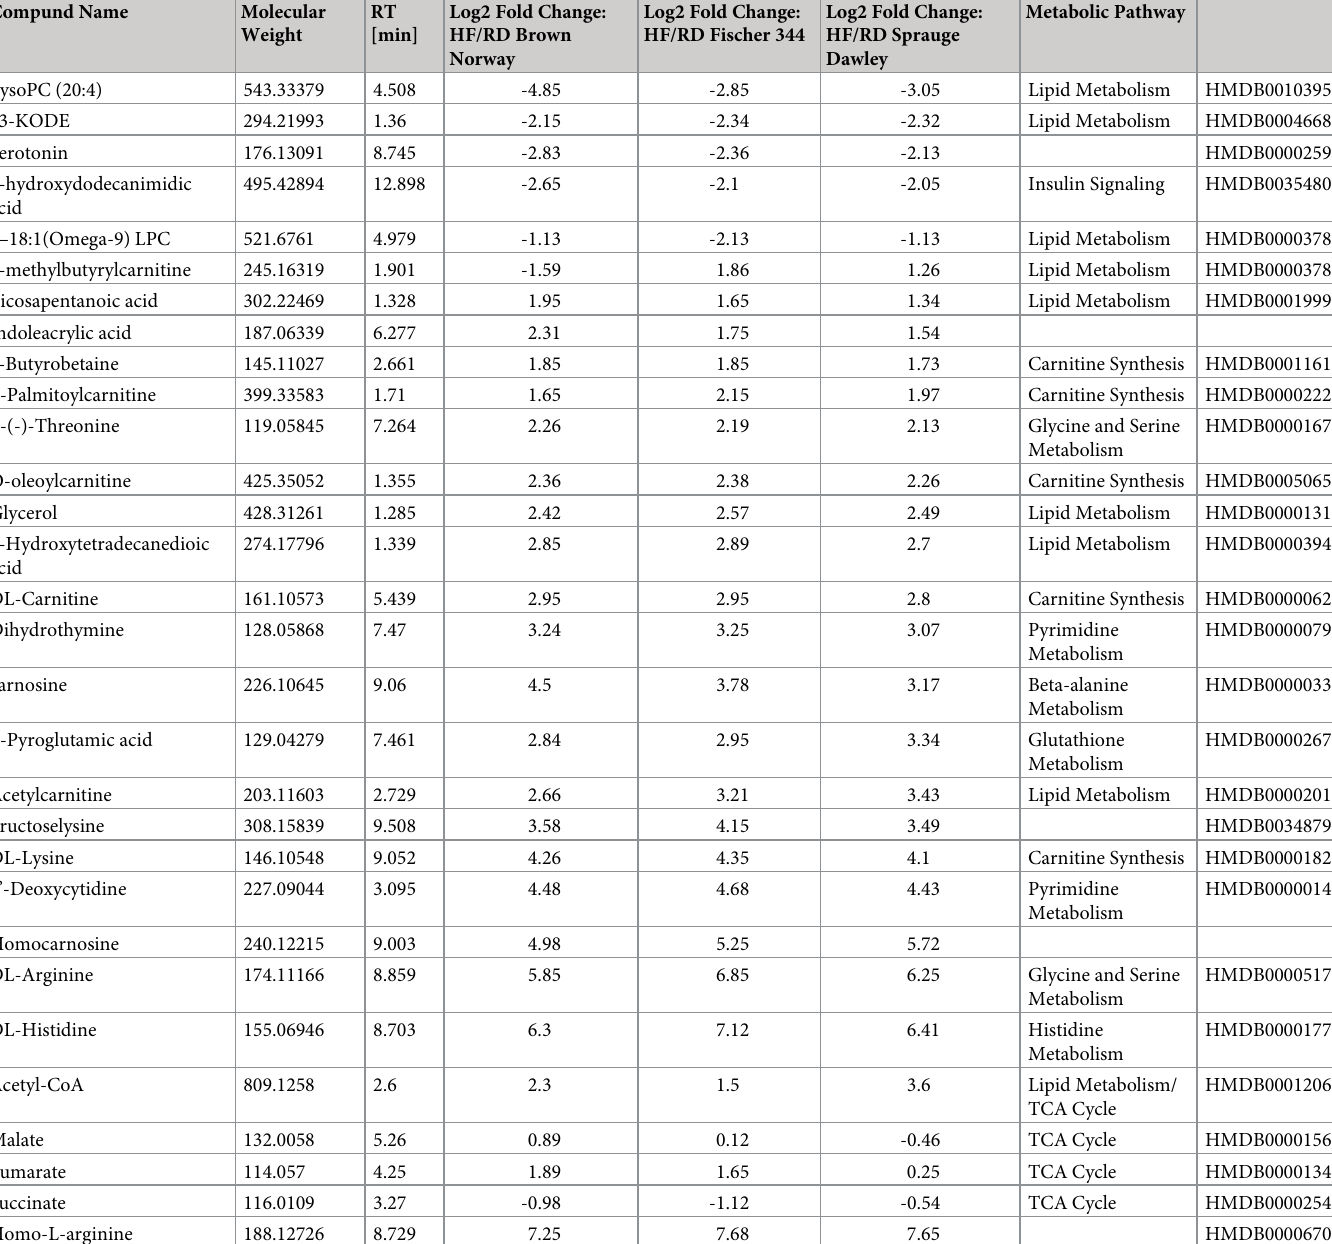
Table 1. Significantly changing metabolites between the high fat diet and regular diet for all three strains. Metabolites identified and confirmed via MS/MS fragmen- tation and spectral library